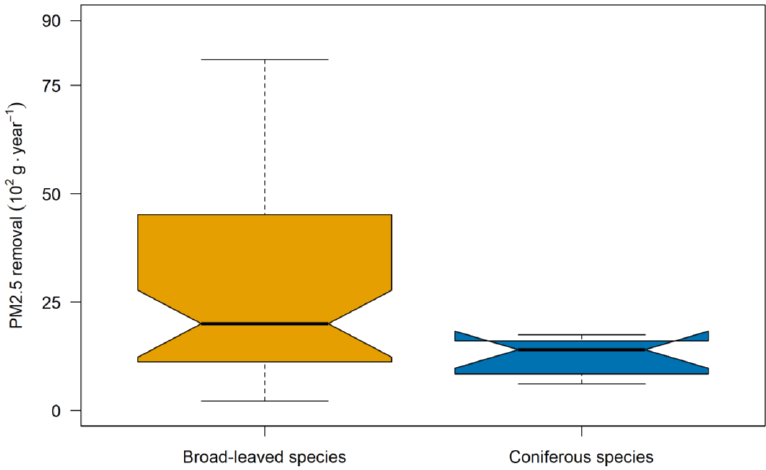
Figure 2. PM 2.5 retention per tree for broad-leaved and coniferous species.